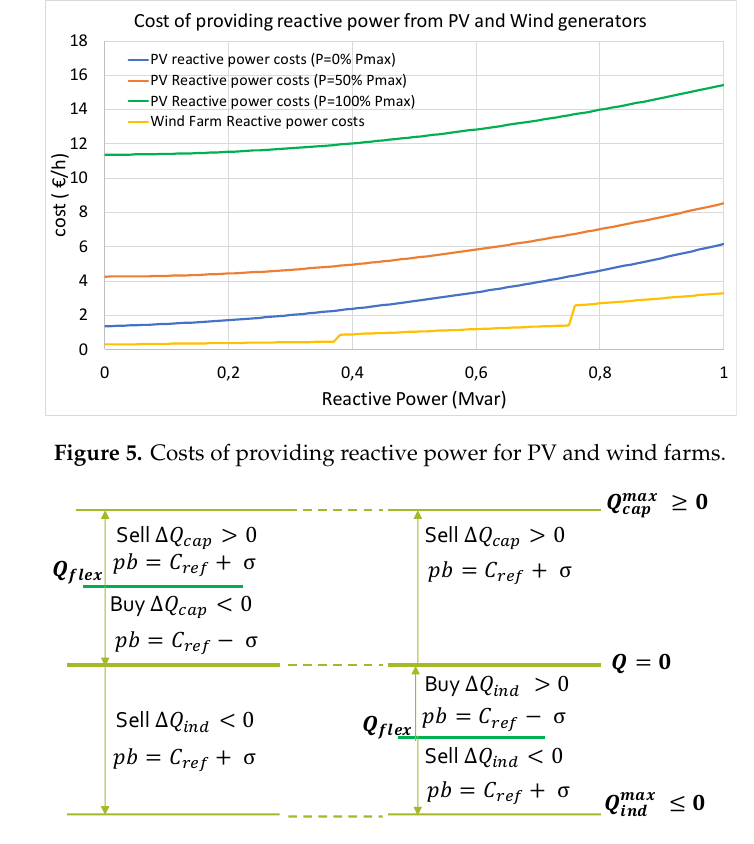
Figure 6. Bids to buy and to sell depending on the reactive operating point of flexible resources.